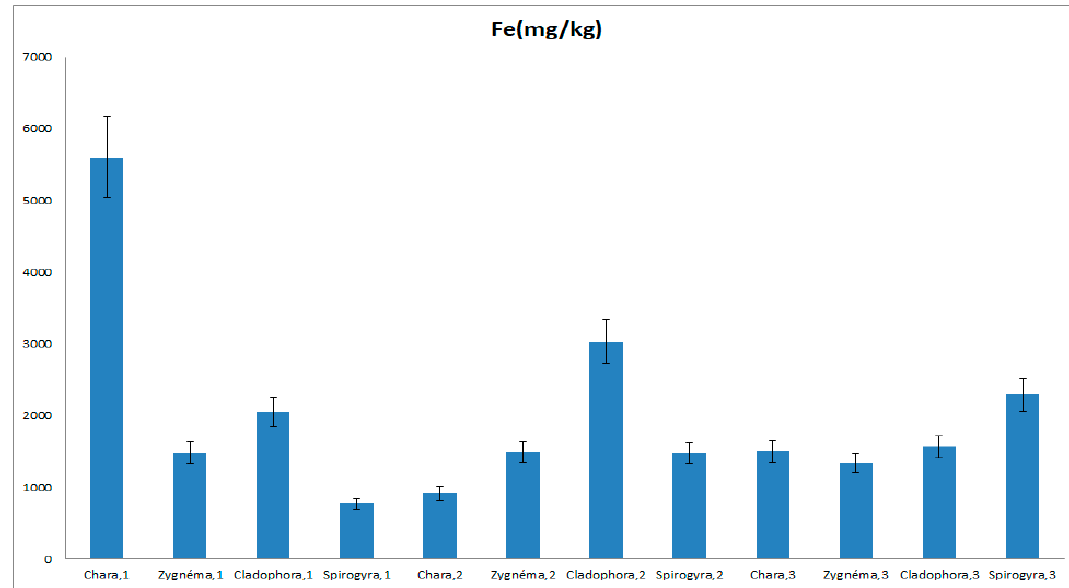
Figure 5. Fe contents of the four algae studied (for the three sites considered).